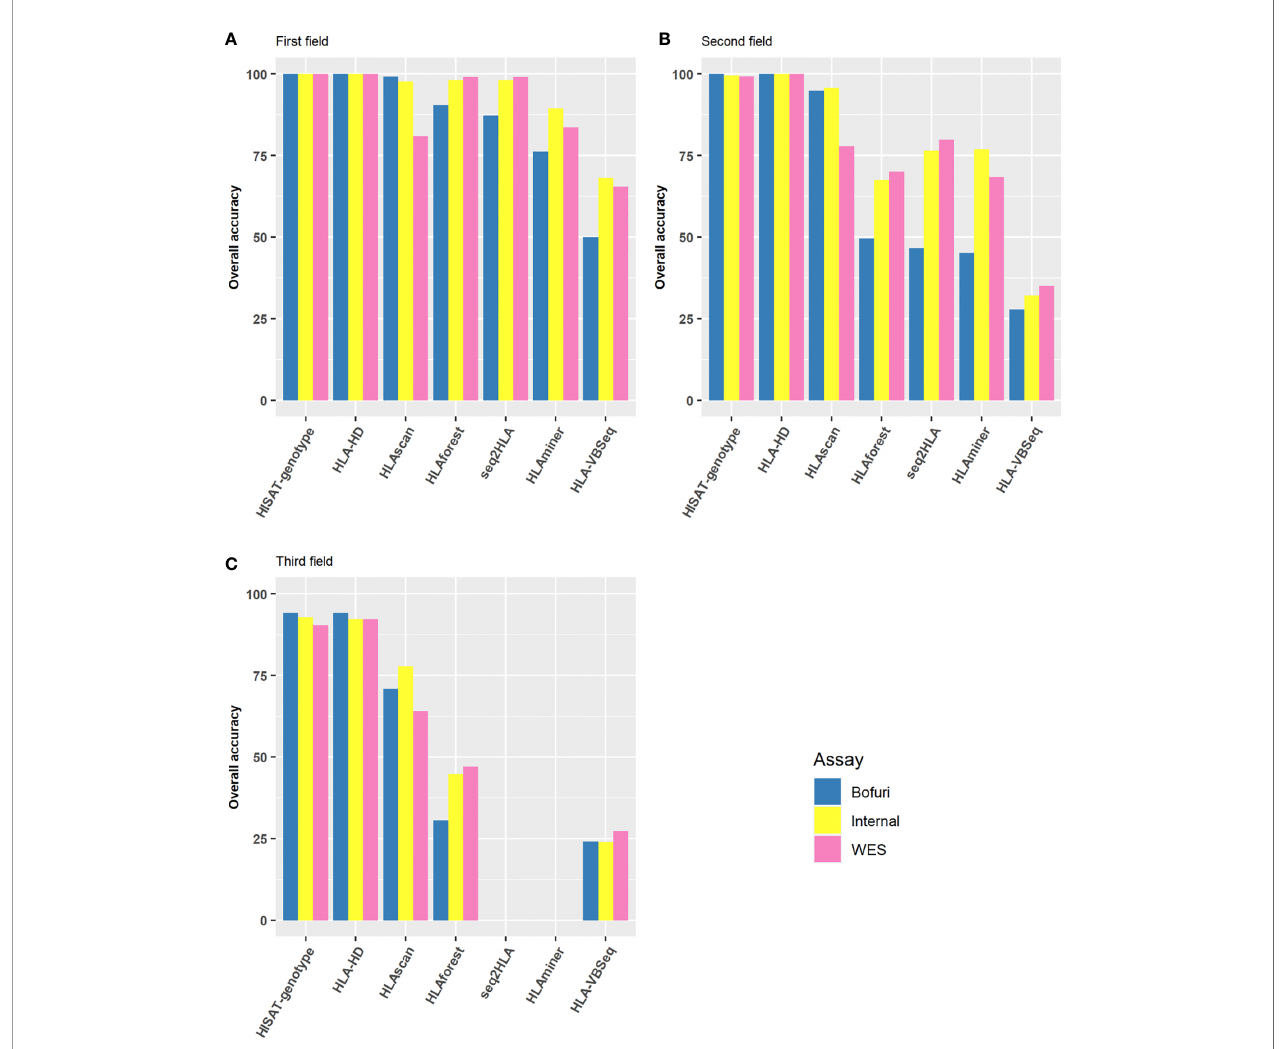
FIGURE 2 | Performance of HLA typing algorithms and the three different HLA assays. Accuracy of HLA alleles typed at (A) the fi rst fi eld level; (B) the second fi eld level; (C) the third fi eld level based on the seven algorithms and three capture assays. Accuracy was calculated by the fraction of total number alleles that were correctly